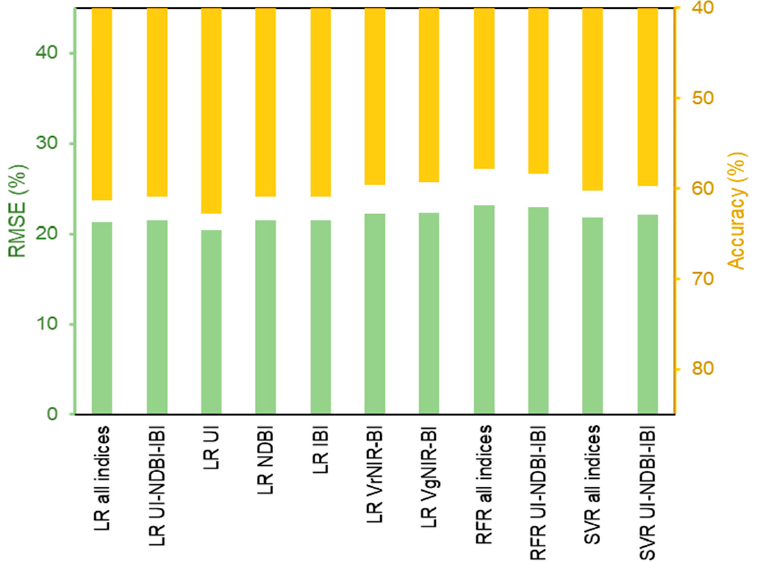
Figure 9. Values of RMSE and upper range of accuracy at 95% confidence level for building density estimation using linear regression (LR), random forest regression (RFR), and support vector regression (SVR) on Landsat 7 data.